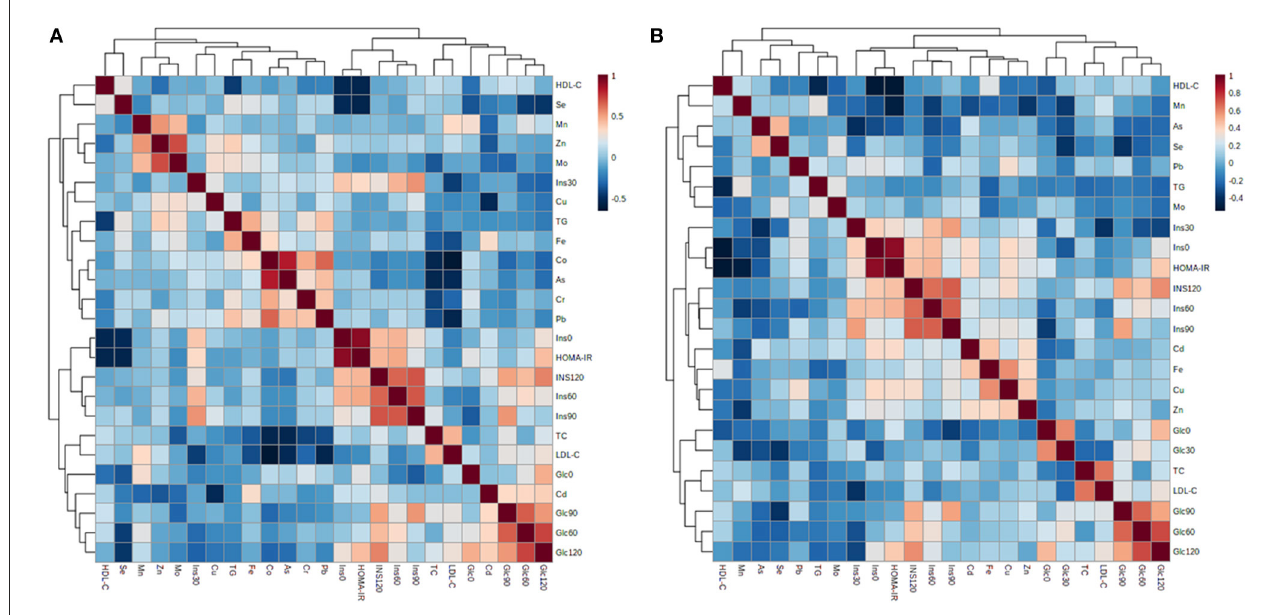
FIGURE2 Pearson’s correlation matrix between biochemical variables and multi-elemental data from plasma (A) and erythrocytes (B) .